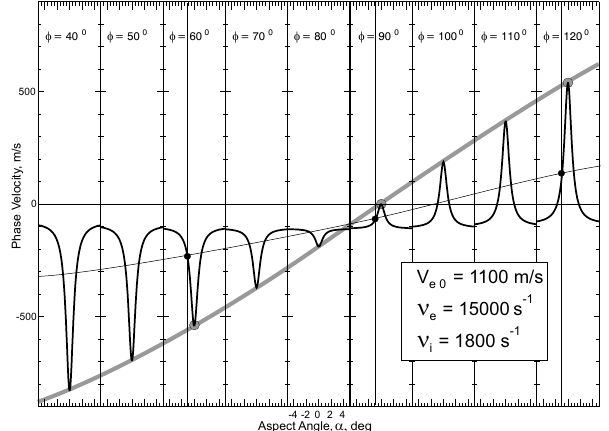
Fig. 7. Phase velocity versus aspect angle α for various L -shell an- gles φ assuming exactly L -shell aligned electron flow ( θ = φ ) V e 0 = 1100m/s and collision frequencies typical for the center of electro- jet region. The large grey (black) circles show the phase velocity at α = 0 ◦ ( α = − 1 ◦ ). The grey thick (black thin) line represents the flow angle variation of the phase velocity for minimum achievable aspect angle of 0 ◦ ( − 1 ◦